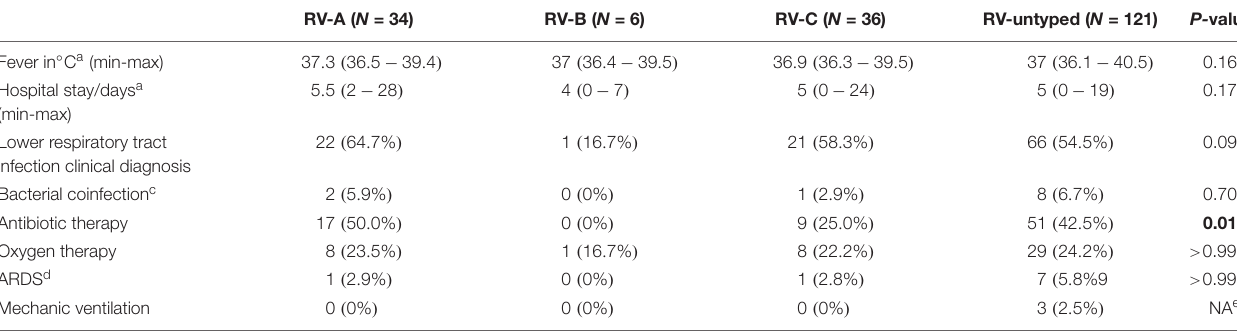
TABLE 2 | Clinical characteristics of children infected with rhinovirus (RV) according to species.